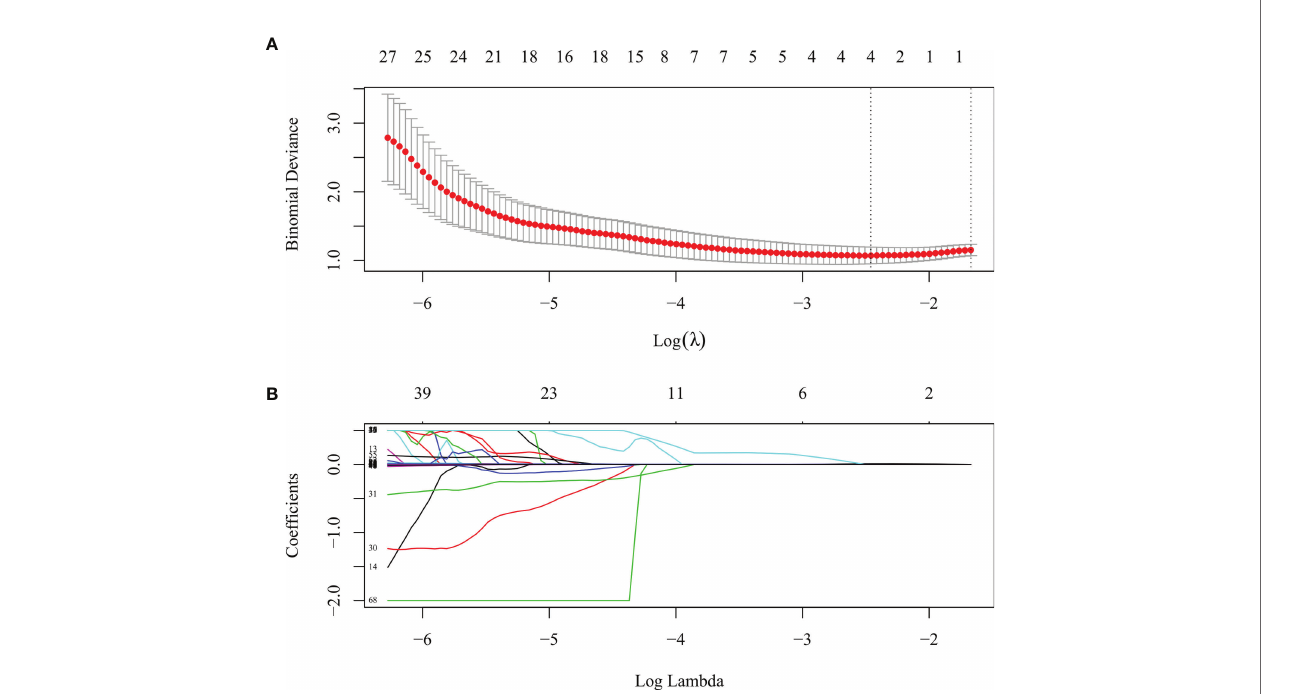
FIGURE 2 | The least absolute shrinkage and selection operator (LASSO) algorithm and 10-fold cross-validation were used to extract the optimal subset of radiomic features. (A) Tuning parameter (lambda, l ) selection in the LASSO model used 10-fold cross validation for the training set. The mean deviance (goodness-of- fi t statistics, red dots) was plotted vs. log ( l ), error bars displaying the range of standard error. Dotted vertical lines were drawn at the point of minimum deviance and at the point where maximum l was obtained among errors smaller than the standard error of minimum deviance. (B) LASSO coef fi cient pro fi les of the 73 texture